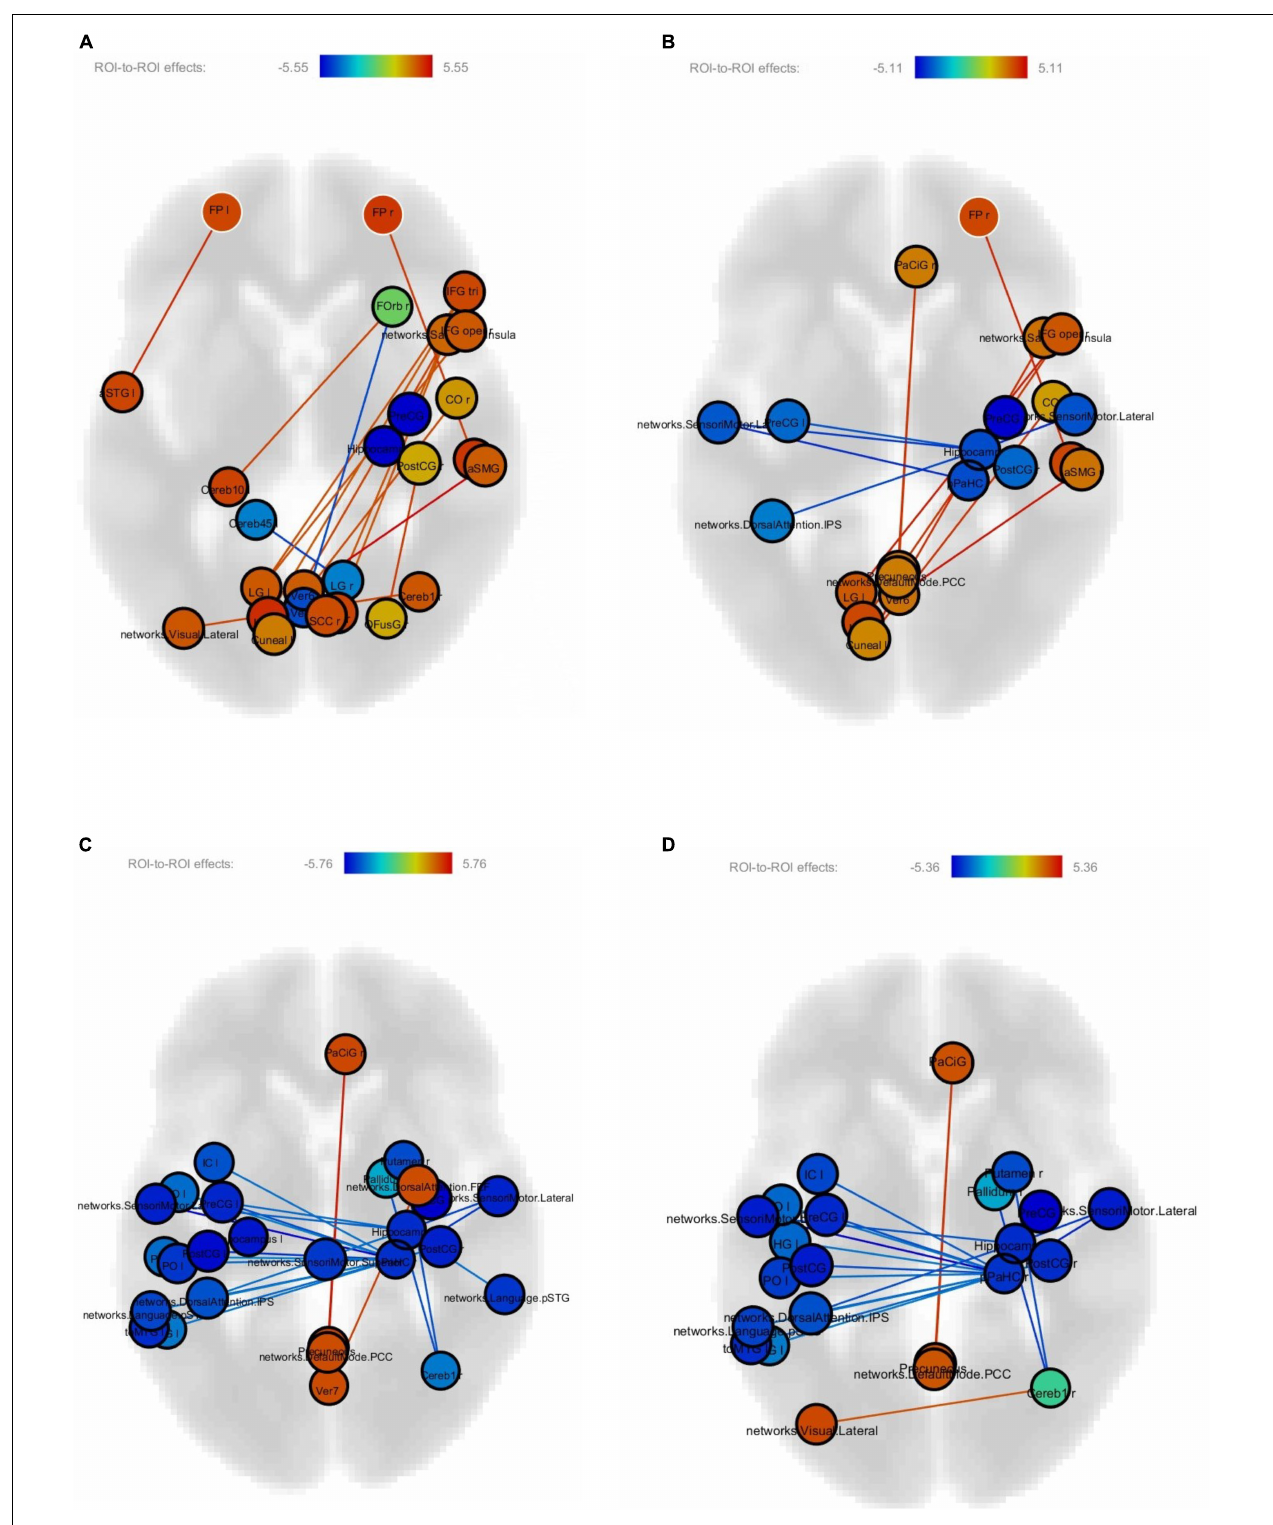
FIGURE 4 | (A) Correlations between connectivity difference and reading speed of difficult non-sensical sentences. (B) Correlations between connectivity difference and reading speed of easy non-sensical sentences. (C) Correlations between connectivity difference and reading speed of difficult meaningful sentences. (D) Correlations between connectivity difference and reading speed of easy meaningful